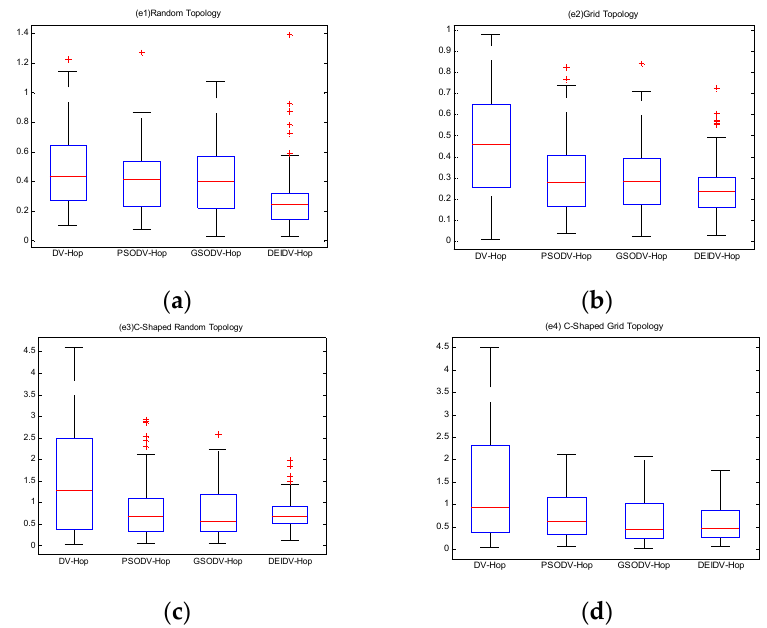
Figure 11. ( a ) The ALE of each unknown node in square random topology; ( b ) The ALE of each unknown node in a square grid topology; ( c ) The ALE of each unknown node in C-Shaped random topology; ( d ) The ALE of each unknown node in C-Shaped grid topology.